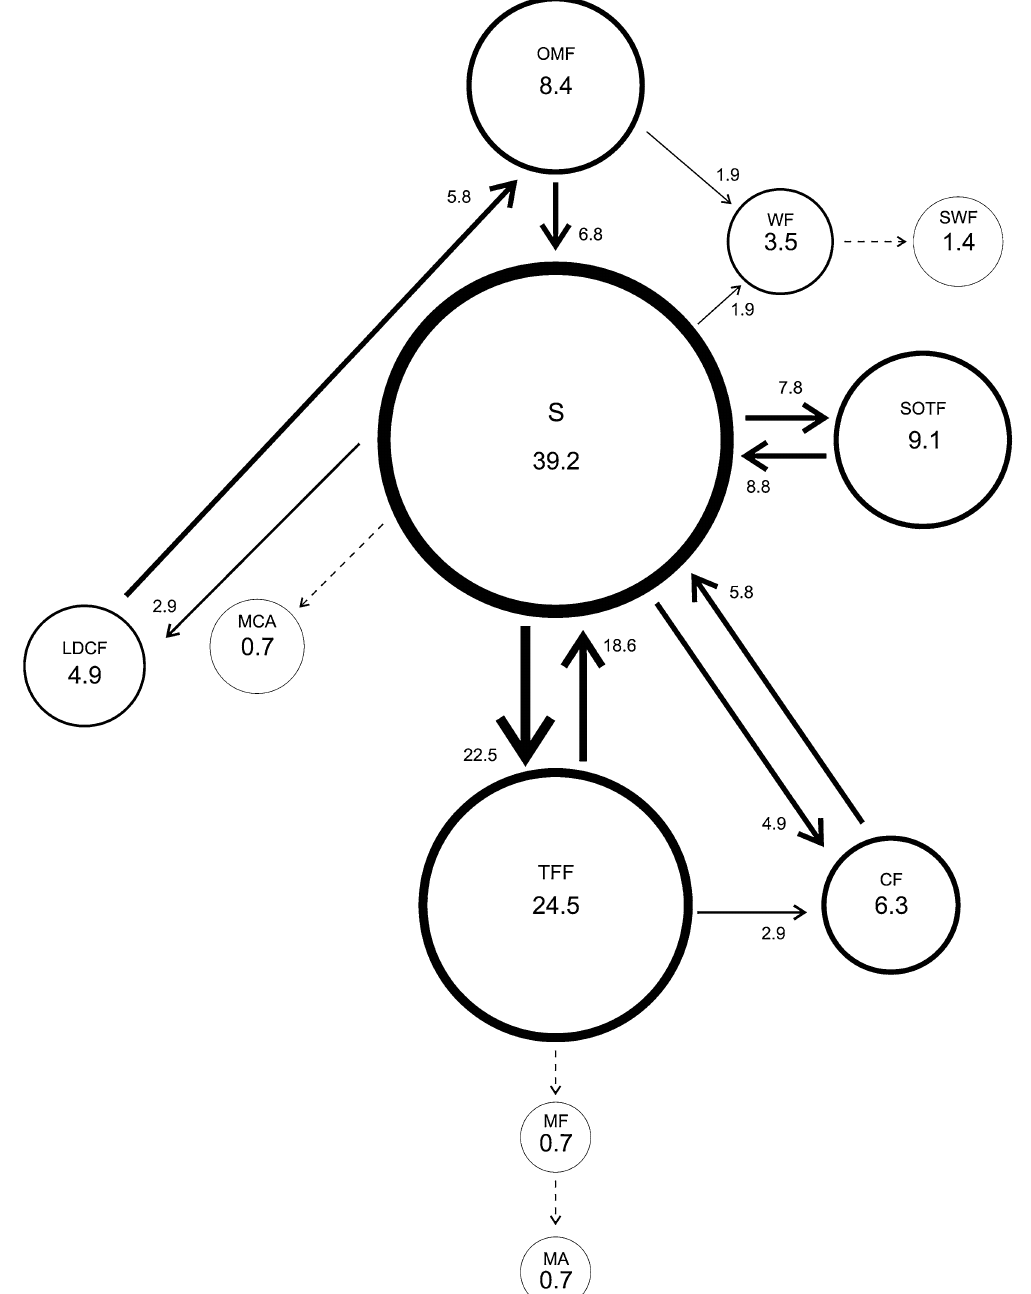
Figure 3. Courtship behavior of Anastrepha curvicauda dominant 7–8 days old males caged with a 5–7 days old virgin female. Circles represent behavioral elements and arrows transitions. Circle size and line thickness are proportional to their percentage values. Dotted lines represent transitions with a median < 1. See Table 1 for